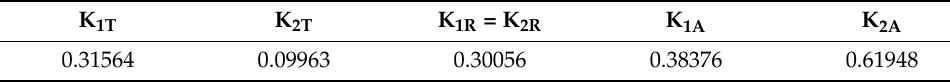
Table 8. Calculated values of K T , K R , and K A for PET